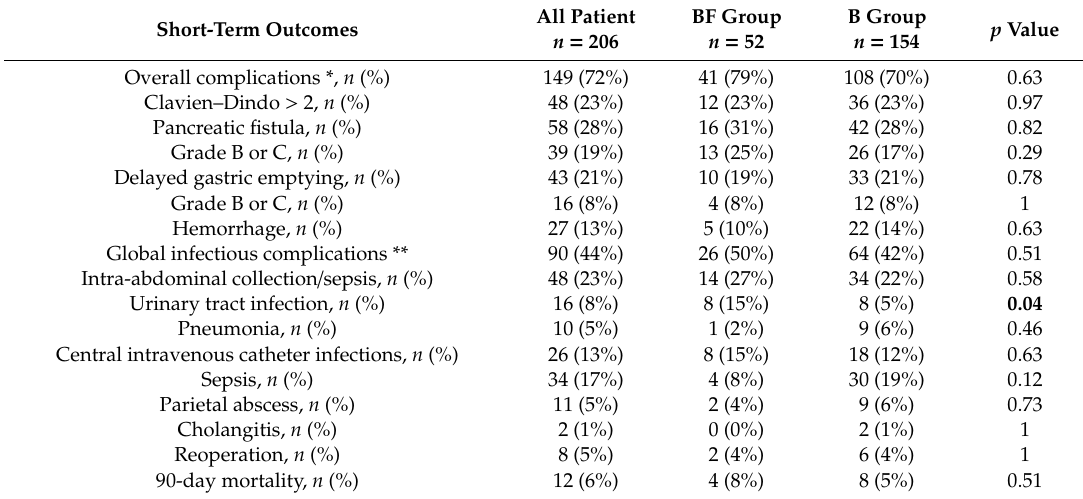
Table 2. Short-term